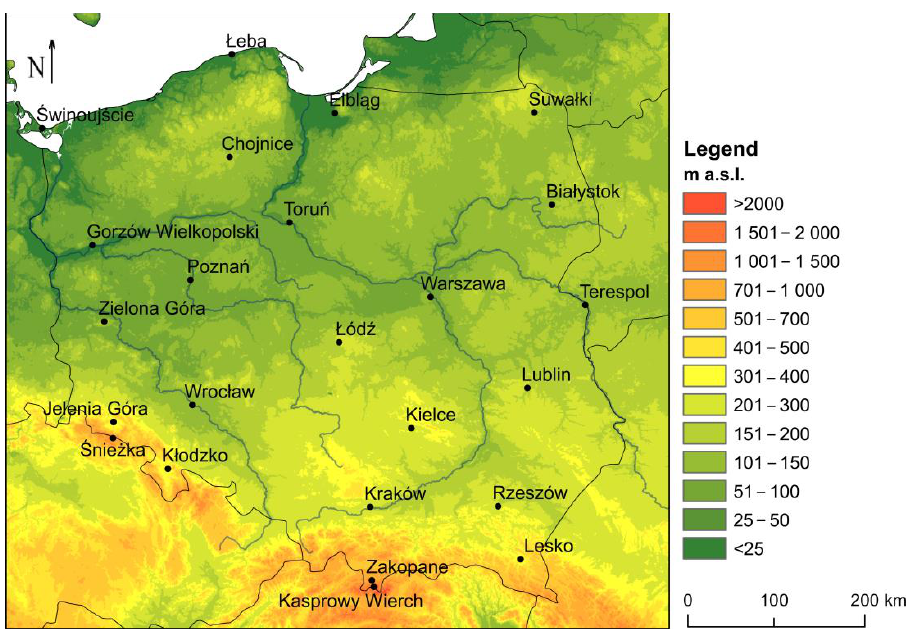
Figure 1. Locations of the analysed stations in Poland.